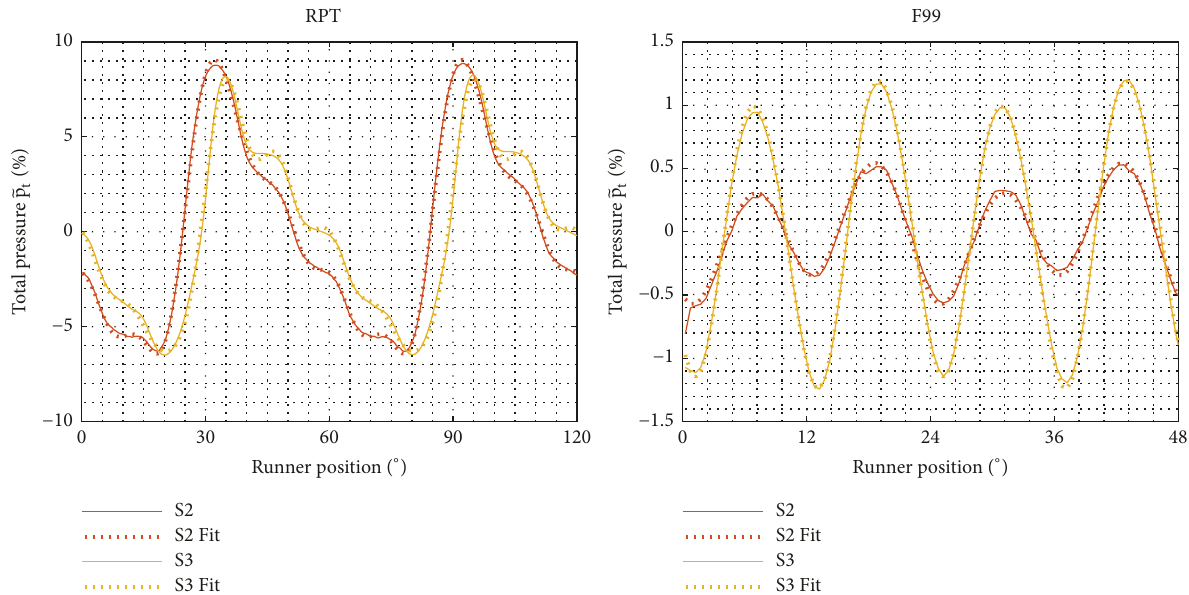
Figure 6: The measured signal and the fit represented with the measurements from sensor S2 and S3.